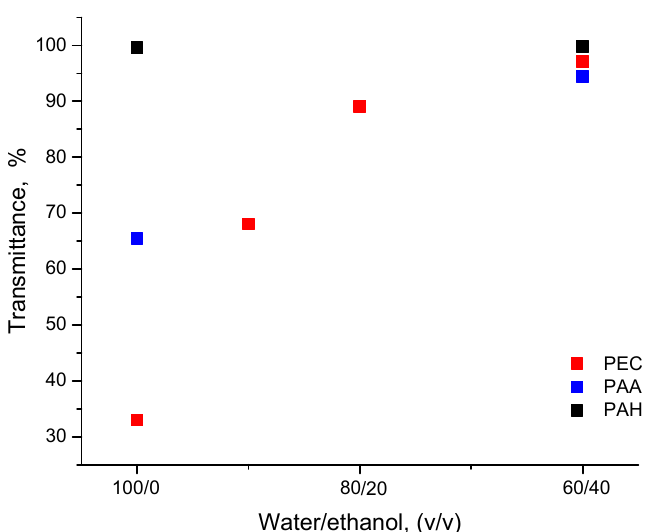
Figure 2. Transmittance of PAA, PAH and PEC solutions with di ff erent water / ethanol composition. Table 1. Relative viscosity of PECs in di ff erent water / ethanol